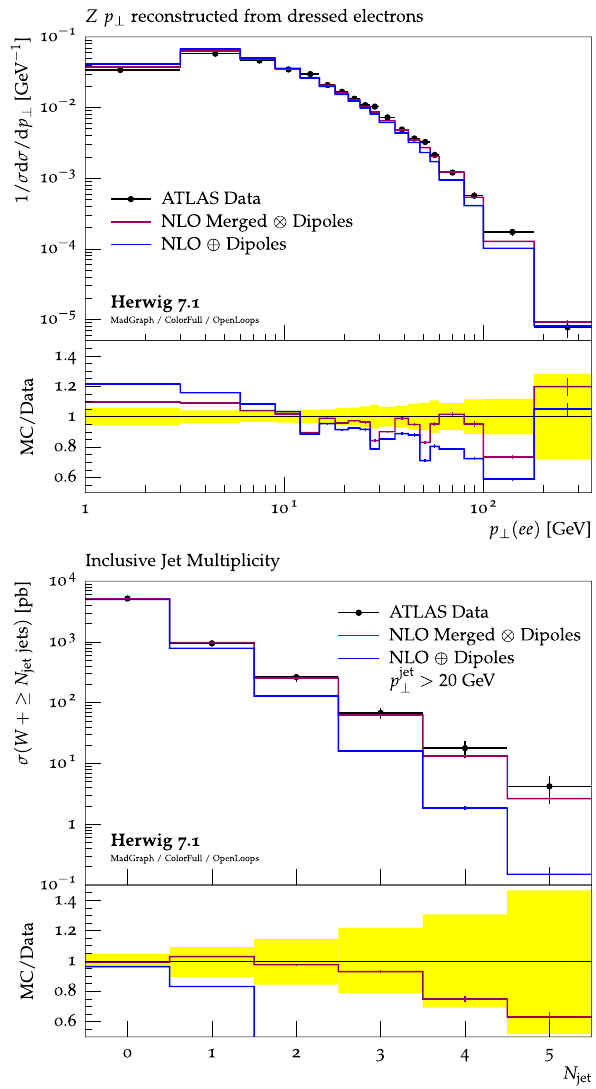
Fig. 1 Thenormalized Z p ⊥ spectrum(toppanel),andjetmultiplicites in W plus jets events (lower panel) as measured by ATLAS [12,13] and comparing the NLO matched prediction with the dipole shower to the NLO multijet merged prediction. Higher jet multiplicities and less inclusive quantities will receive bigger corrections through the merg- ing algorithm. For these results we have used our run-time interfaces to MadGraph5_aMCatNLO [14] and OpenLoops [15] to evaluate scattering amplitudes for each phase space point, and ColorFull [16] to perform the colour algebra